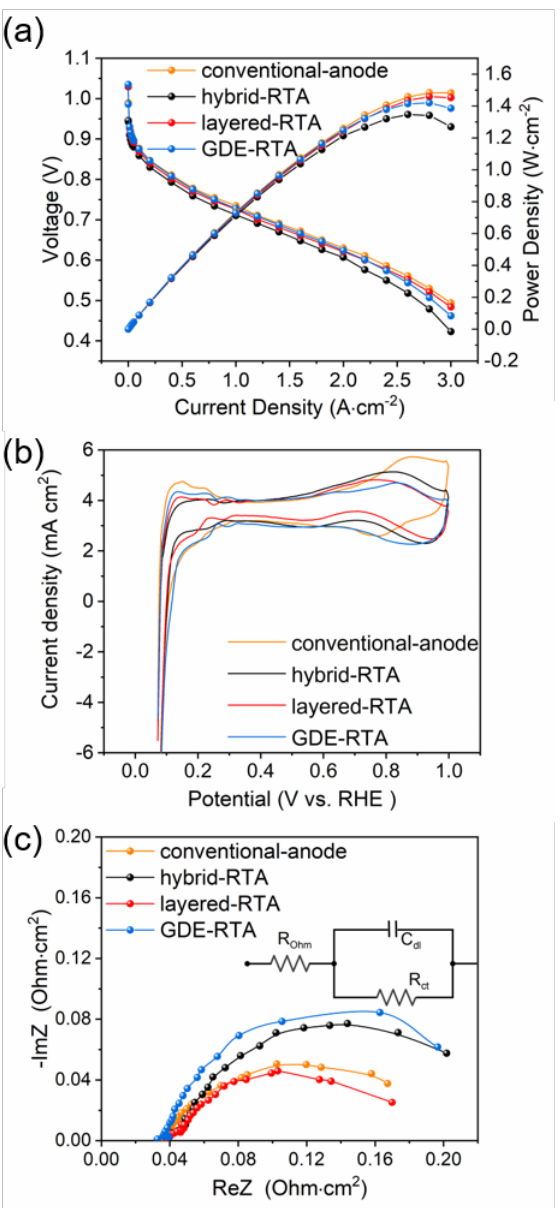
Figure 3. Electrochemical characterization of fresh MEAs: I–V and power density curves ( a ), cyclic voltammograms ( b ), and Nyquist diagrams ( c ). Table 2. Reversal tolerance time and electrochemical data analysis of fresh